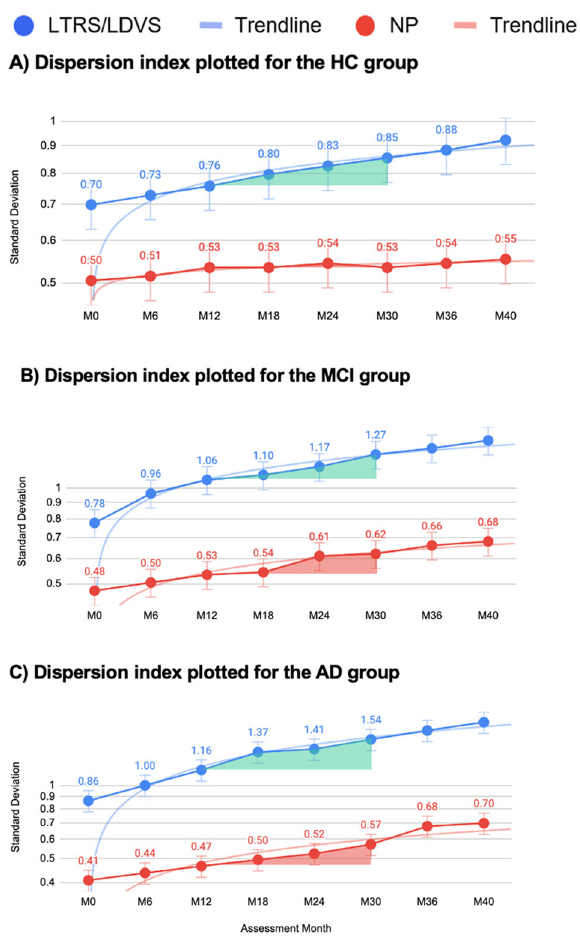
Fig. 2 Dispersion index based on LTRS and NP plotted for for the HC ( A ), MCI ( B ), and AD ( C ) groups translated into standard deviation. The A – C graphs show a nonlinear increase in standard deviation as a function of disease trajectories. Comparing the overall mean of LTRS vs NP per group yields the following values: HC: t = 10.00106, p < 0.00001; MCI: t = 7.02195, p < 0.00001; AD: t = 6.65272, p = 0.000011, the results are statistically signi fi cant at p < 0.001. Details of the individual time points are shown in Table